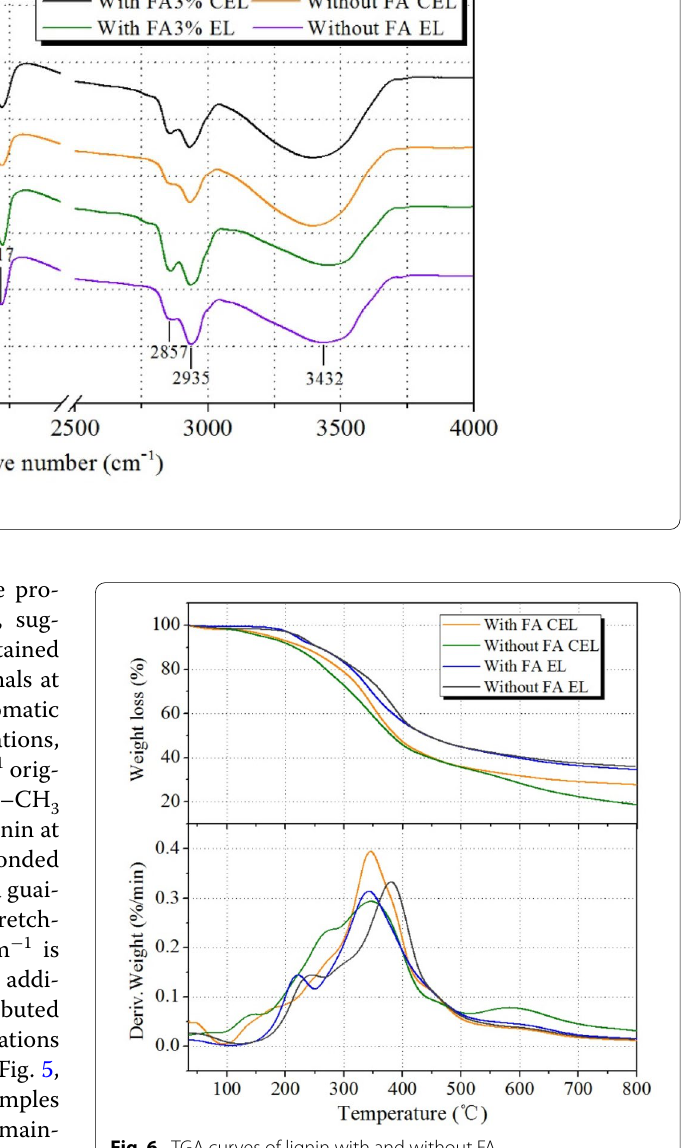
Fig. 6 TGA curves of lignin with and without